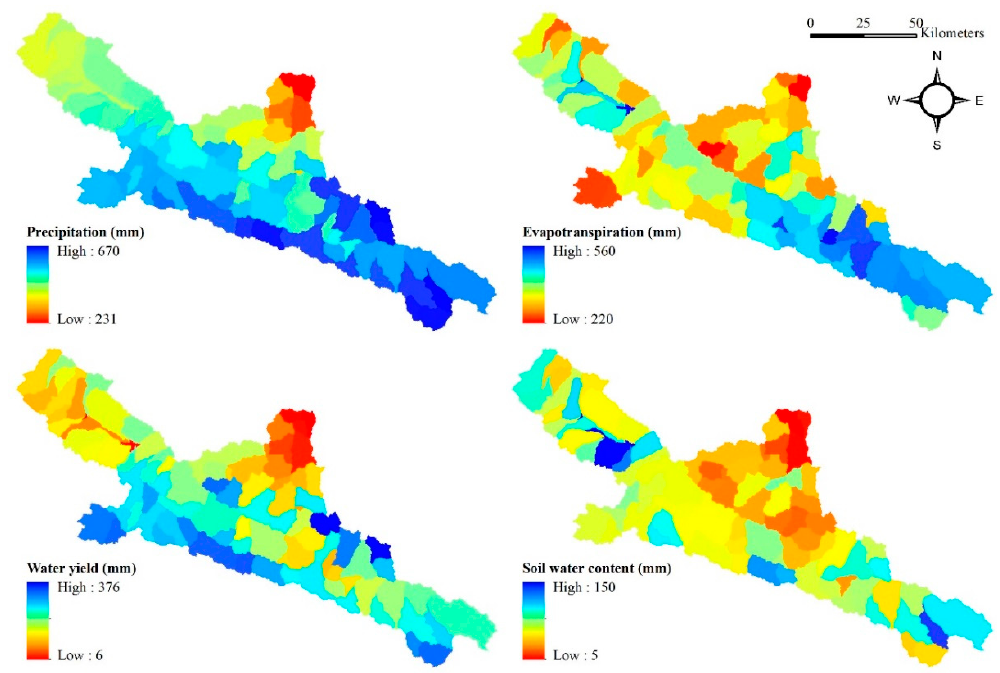
Figure 13. Annual average value of the water balance components at the sub-basin scale from 2003 to 2014.